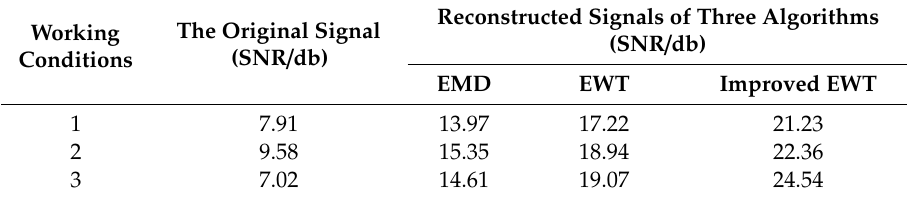
Table 1. Signal-to-noise ratio (SNR) before and after signal processing.